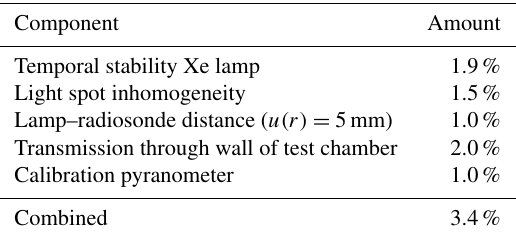
Table 2. Uncertainty budget for irradiance ( k = 1). Values are given as relative to applied